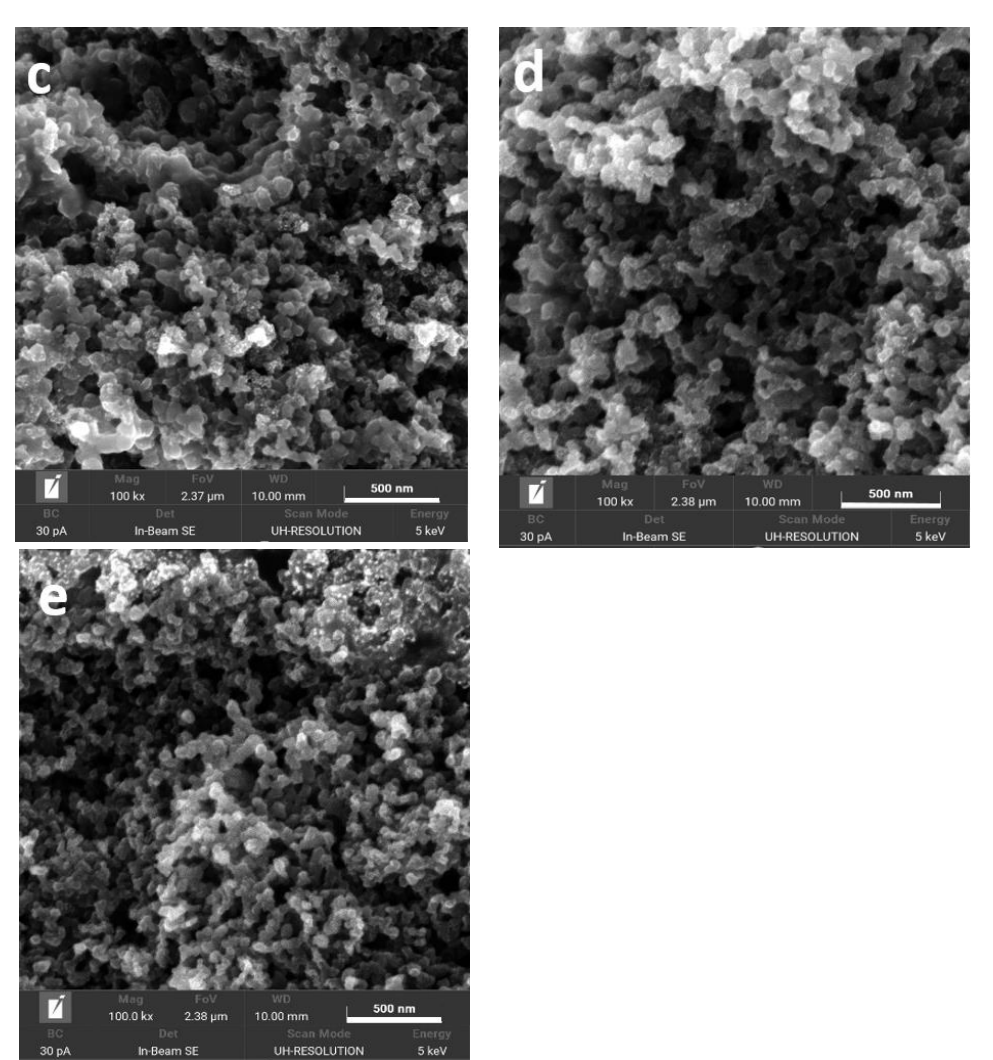
Figure 7. FIB-SEM images of the cathode CLs (cross-section) of the MEAs prepared with ( a ) TKE, ( b ) TKV, ( c ) Pt/CB, ( d ) Pt/C65, ( e ) Pt/GC catalysts.